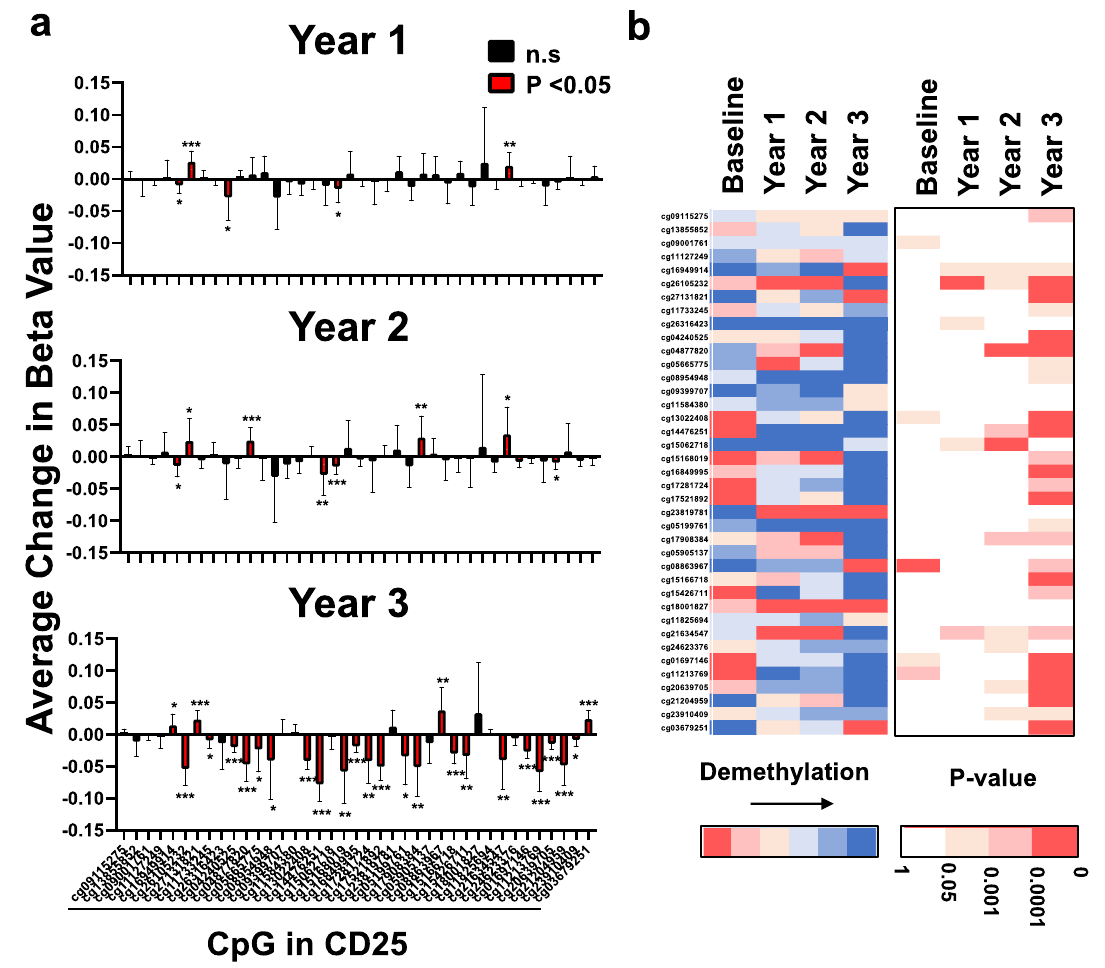
Figure 4. The Treg associated CD25 gene (IL2 receptor) of potent Treg cells after in vivo BCG treatment shows gradual, significant, and a three year decreases in methylation. ( a ) Methylation changes for the individual CpG sites (n = 39) of the CD25 gene after BCG vaccine therapy were quantified compared to baseline. Average yearly changes in Beta values of CD25 CpG sites is shown at Year 1, Year 2 and Year 3 for multi-dosed type 1 diabetic subjects (n = 13). Beta value differences were calculated for each patient relative to baseline. The data for each CpG is color coded separately (p value < 0.05: *; p value < 0.01: **; p value < 0.001: ***). Red bars represent statistically significant change in methylation. ( b ) The heat map shows average difference in Beta values for individual CD25 CpGs sites at yearly intervals. Increased blue coloration in the heatmap means increased demethylation of the CpG sites within the CD25 gene. The right heatmap indicates the p-values in the corresponding CpG sites; Blank and red indicate without or with significance, respectively, and degree of red color reflects the strength of